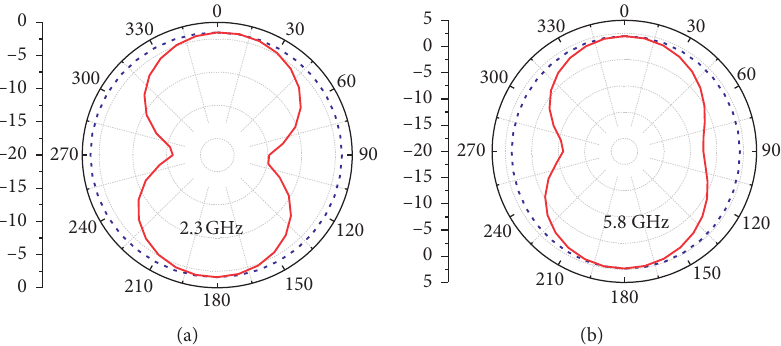
Figure 8: 2D radiation pattern of the ram horn-like folded antenna.